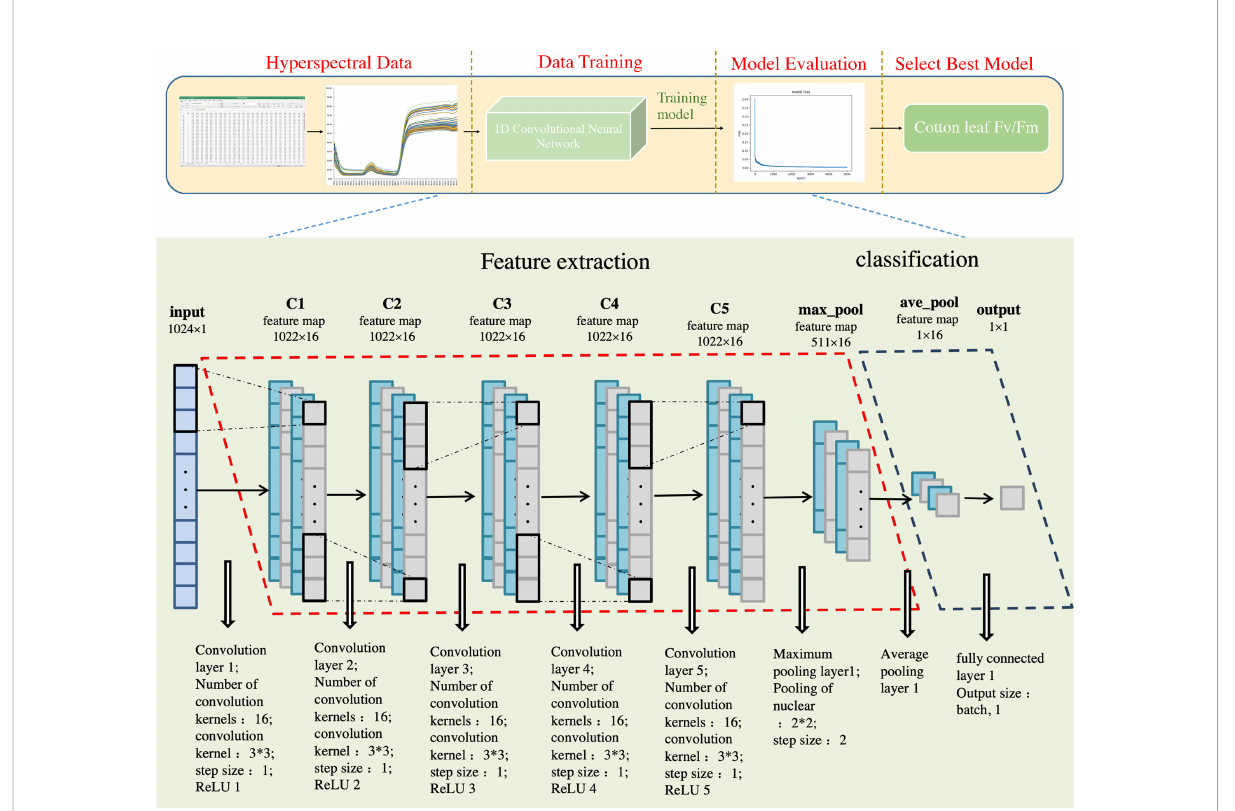
FIGURE 2 Flow chart illustrating 1D-CNN data processing. The training set accounts for 75% and the test set 25%. A matrix was created with 72 rows, 1024 columns, and a dimension added to the training set channel. Another matrix was created with nine rows, 1024 columns, one channel number, zero elements, and a dimension was added to the test set channel. Finally, an empty deep learning model named “ model ” was de fi ned. Next, fi ve one-dimensional convolution layers were added (corresponding to fi ve ReLU activation functions), including 16 convolution cores measuring 3 x 3 and a step length of one. The fi rst maximum pool layer was added, and the pool core size was 2 x 2, and the step distance was two. The fi rst global average pooling layer was then added, yielding the fi rst full connection layer; the output size was (batch, 1). The RMSProp optimizer was then de fi ned with a learning rate of 0.001, the gradient decay rate of 0.9, the fuzzy factor was zero, and the learning rate decay rate was zero. The MAE loss function and RMSProp optimizer were then used. The framework of the in-depth learning model was integrated, and data was transferred to the de fi ned model by training 5000 epochs; the amount of data in each batch was 5. Finally, the table was given a title, and the image displayed. The test code is the same as the above training